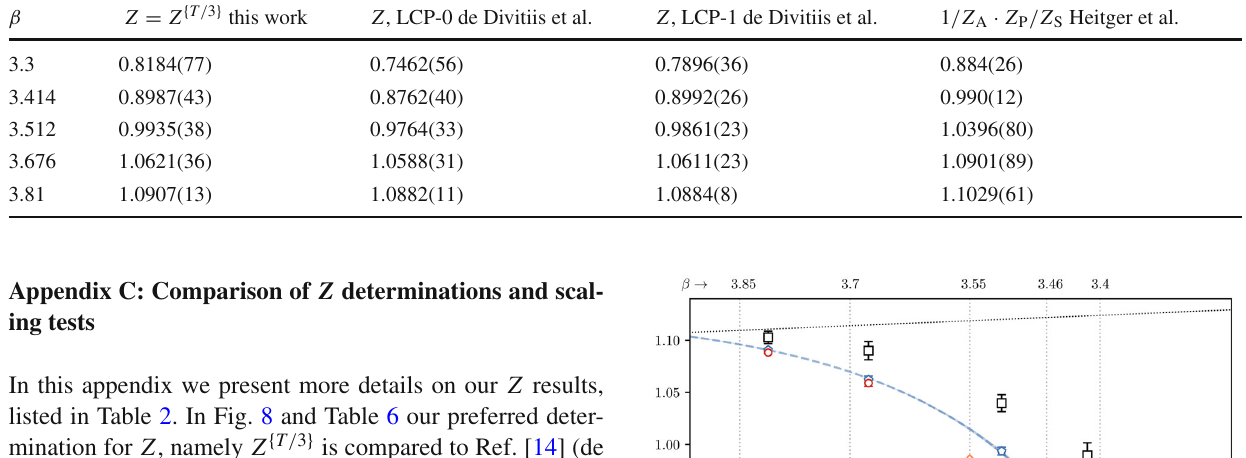
Table 6 Comparison of our preferred Z determination with results from Ref. [14] (de Divitiis et al.) and the combination of results from Refs. [24,49] (Heitger et al.) β Z = Z { T / 3 } this work Z , LCP-0 de Divitiis et al. Z , LCP-1 de Divitiis et al.